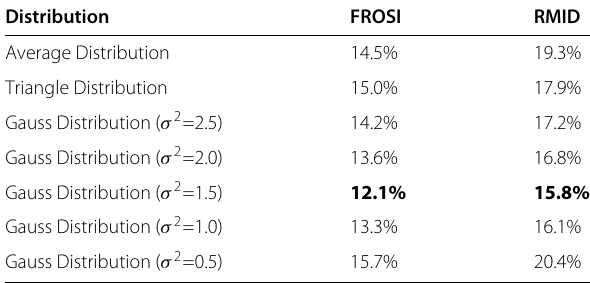
Table 2 Results of different label